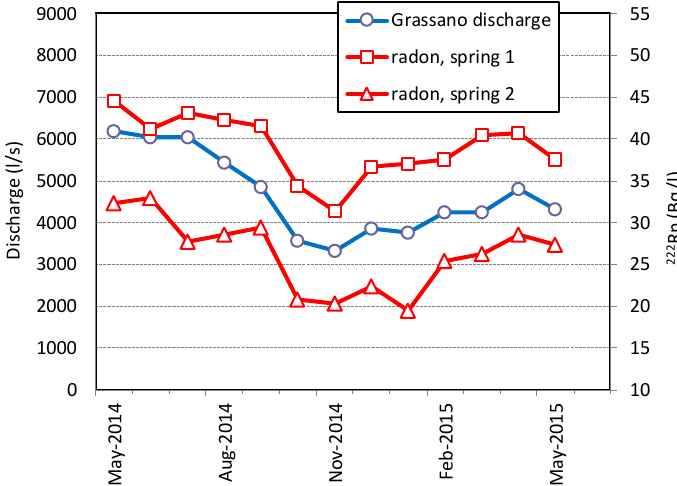
Figure 7. Temperature and electrical conductivity measured in the Grassano river, just below spring outlets; monthly measurements from May 2014 to May 2015 (modified from Fiorillo et al. [33]).